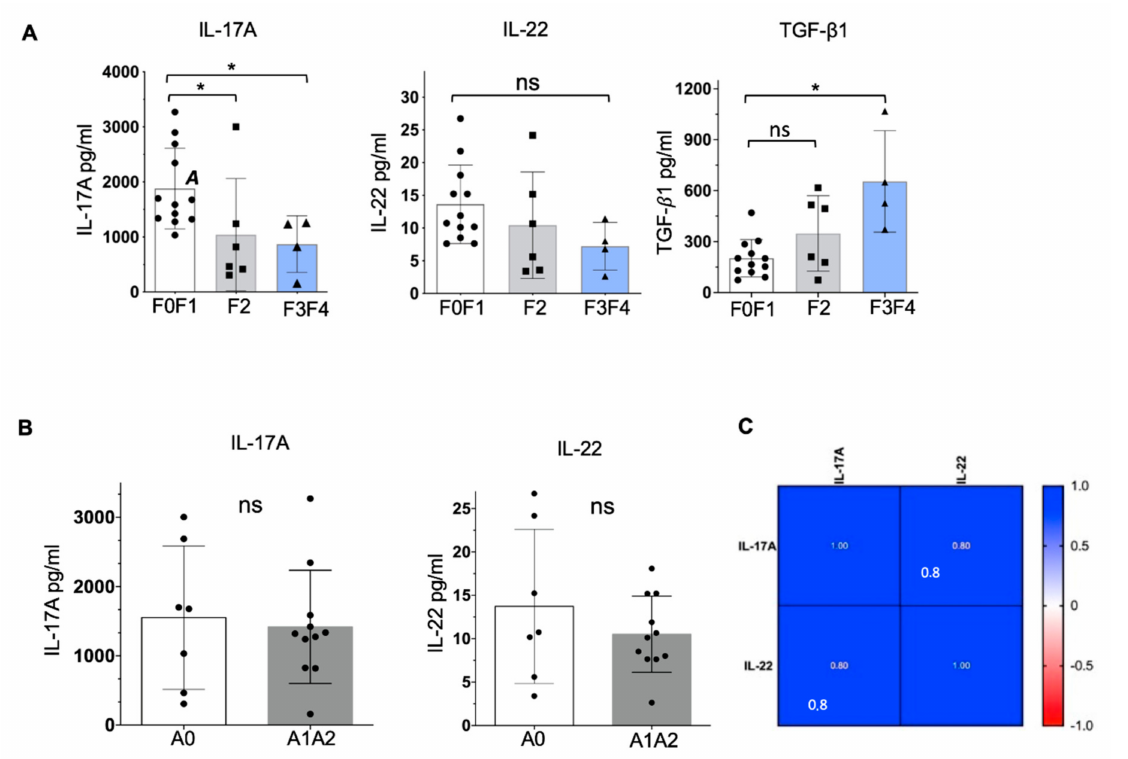
Figure 1. Different IL-17A, IL-22, and TGF- β 1 expression in human liver tissue depending on the stage of liver fibrosis. Twenty-two post-surgery human liver samples with different fibrosis stages were lysed, and analyzed by ELISA for IL-17A, IL-22, and TGF- β 1. ( A ) IL-17A, IL-22, and TGF- β 1 expression in human liver samples at different stages of fibrosis (Kruskal–Wallis test with Dunn’s multiple comparisons correction; * p < 0.05; ns: not significant). ( B ) The IL-17A and IL-22 expression in liver tissue was independent of inflammatory activity (Mann–Whitney test; ns: not